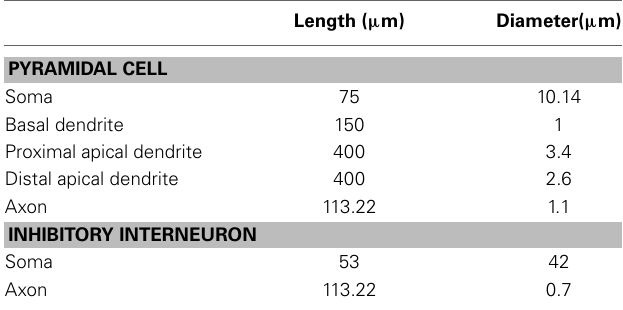
of synapses each pyramidal sends to the other (5 synapses). Purple trace corresponds to iNMDA-to-iAMPA ratio = 1.5, blue to iNMDA-to-iAMPA ratio = 1.9, green to iNMDA-to-iAMPA ratio = 2.3. Yellow trace: Voltage clamp trace of the NMDA current for iNMDA-to-iAMPA ratio = 2.3, where the decay time constant τ NMDA is reduced from 107ms to 18ms. (D) Validation of the kinetics and iNMDA-to-iAMPA ratio of the interneuron model. Left: experimental trace (reprinted with permission from Wang and Gao, 2009), showing the response in the soma of a fast spiking interneuron after stimulation of a pyramidal neuron under voltage clamp conditions at − 70mV (iAMPA) and at + 60mV (iNMDA). Right: model reproduction of AMPA ( − 70mV) and NMDA ( + 60mV) currents under the same protocol using the same number of synapses a pyramidal neuron sends to the interneuron (2 synapses). (E) Validation of the autaptic inhibitory current. Left: experimental trace of autaptic inhibitory current in response to voltage clump steps from − 70 to + 10 for 1ms (reprinted with permission from Bacci et al., 2003). The current disappears after application of the GABAA blocker gabazine. Right: Reproduction of the results using the same protocol in the model. and inhibitory interneurons in the